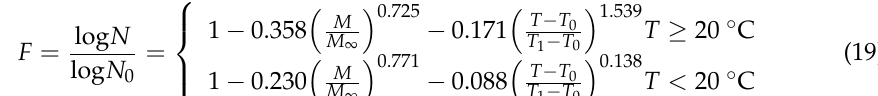
Figure 10. Fatigue life under different hygrothermal conditions. ( a ) Fatigue life; ( b ) Normalization of logarithmic life.